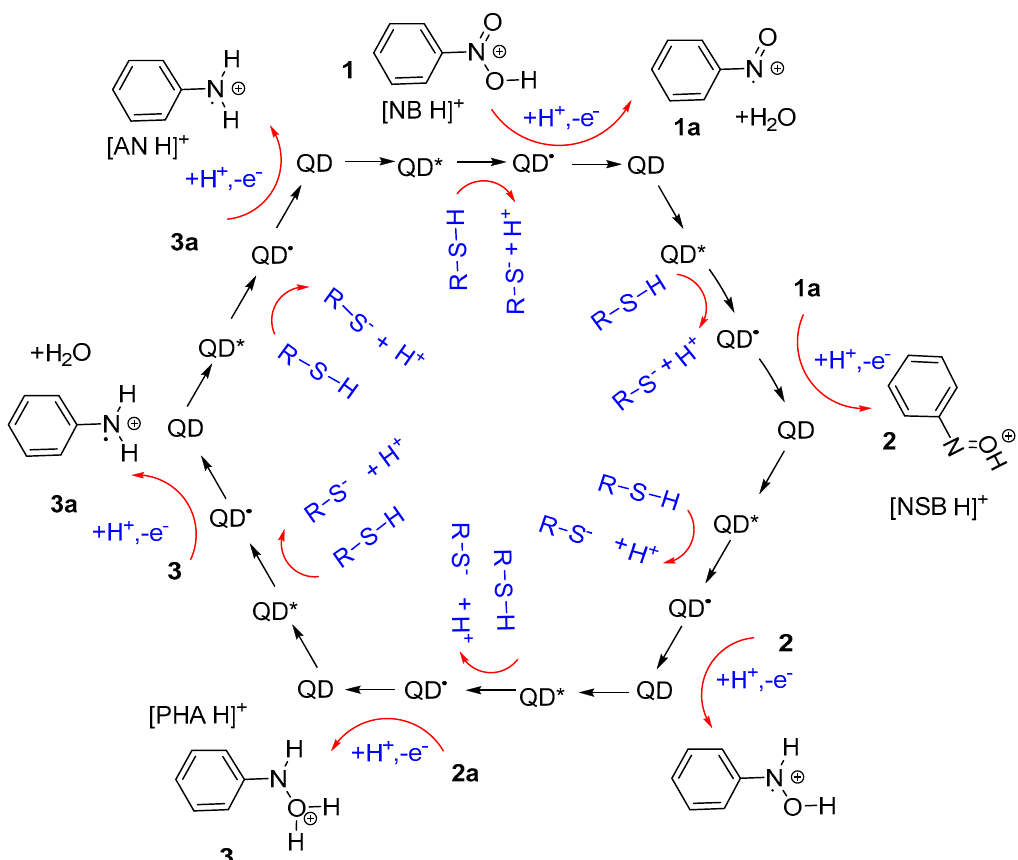
Scheme 1. Mechanism of the entire process of nitrobenzene converting to aniline on the acidic condition. Reprinted with the permission of ref. [27], Copyright 2016 @American Chemistry Society.